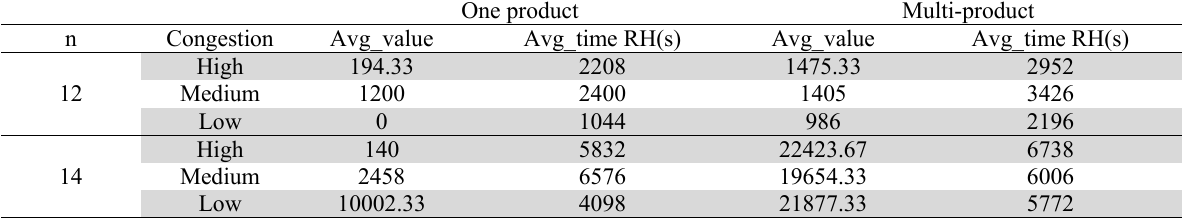
The results of the rolling horizon algorithm for large instances ( α =0.5) One product